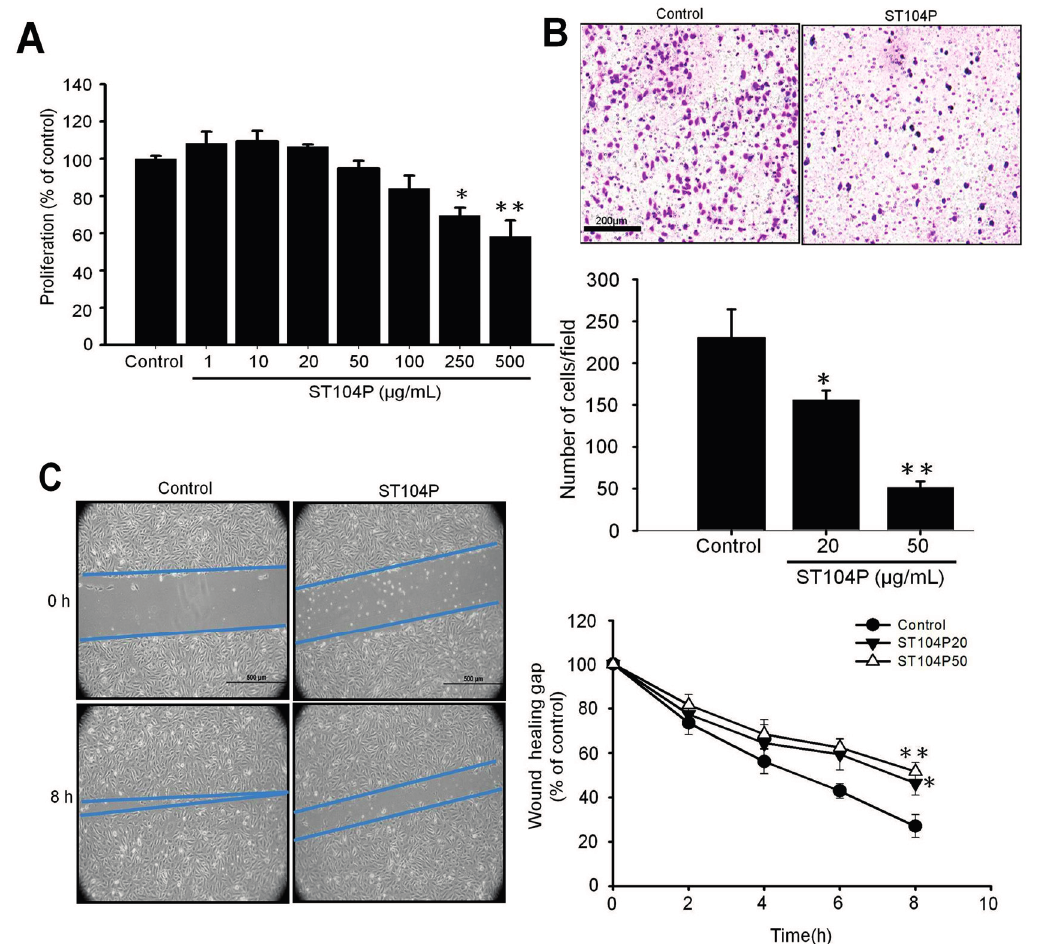
Figure 4. Effect of ST104P on various angiogenic processes in cultured endothelial cells. ( A ) Effect of ST104P on proliferation of human umbilical endothelial cells